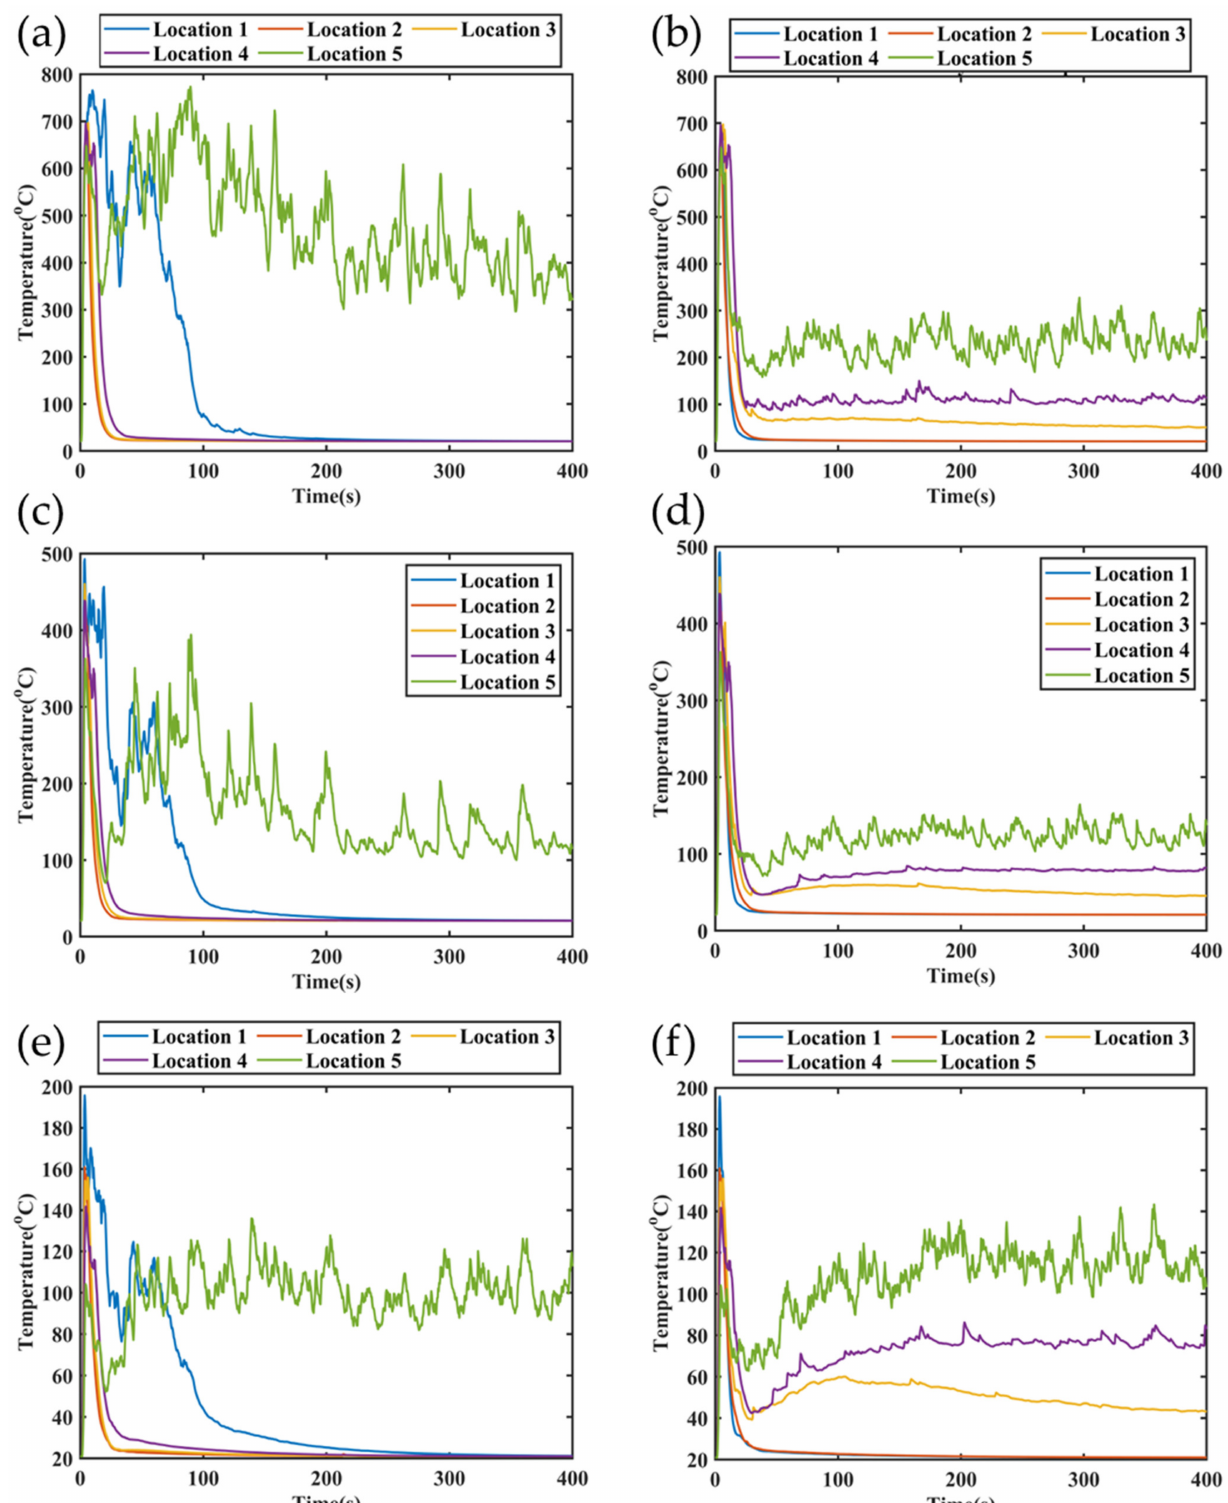
Figure 6. Temperature profile of each fire location at height of 0.2 m ( a ) fire sprinkler; ( b ) water mist.; 0.5 m ( c ) fire sprinkler; ( d ) water mist and 1.2 m ( e ) fire sprinkler; ( f ) water